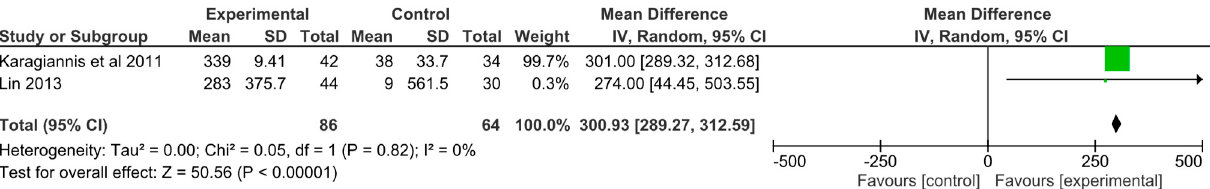
Figure 2. Forest plot of the results from random effects meta-analysis on fluid intake. Results are presented as mean difference (MD) between baseline and post intervention with the corresponding 95% confidence interval.